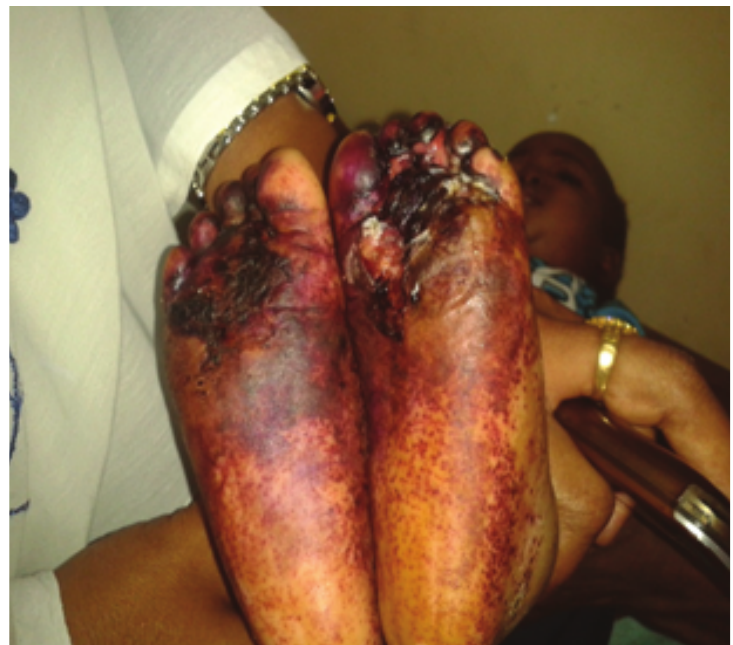
Figure 2: Hemorrhagic crust and purpura.